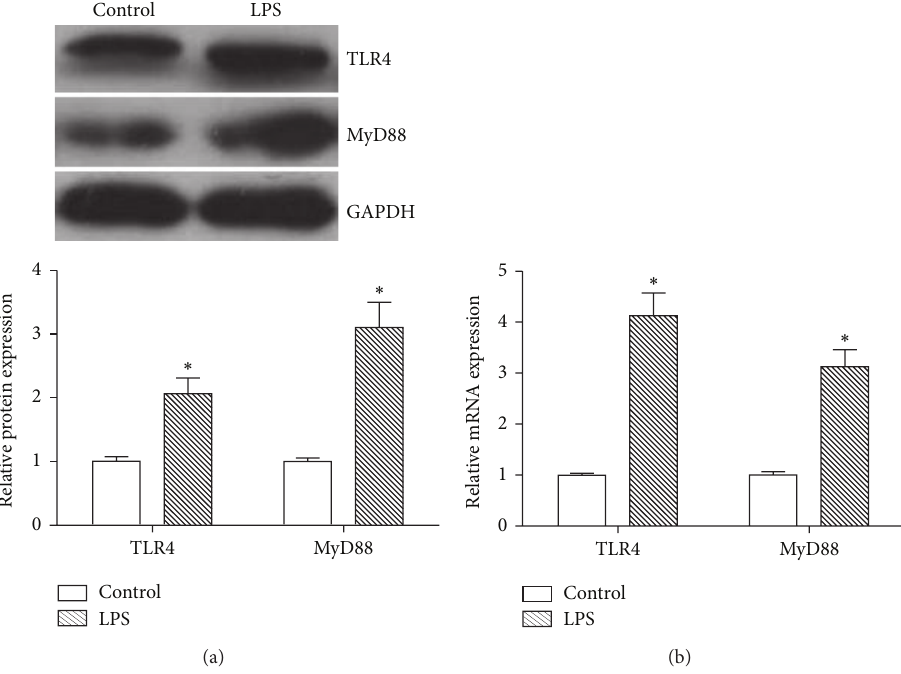
Figure 4: LPS induced TLR4 and MyD88 expression in SFs. SFs were treated with LPS (100ng/mL) for 6 h or 12h. Cell lysates were collected (at 12 h) for analyzing the protein expression of TLR4 and MyD88 (a) by Western blot. Total RNAs were extracted (at 6 h) for detecting mRNAs of TLR4 and MyD88 (b) by real-time quantitative PCR. Data shows all the values from independent samples of 𝑛 = 3 , ∗ 𝑃 < 0.05 versus nonstimulated